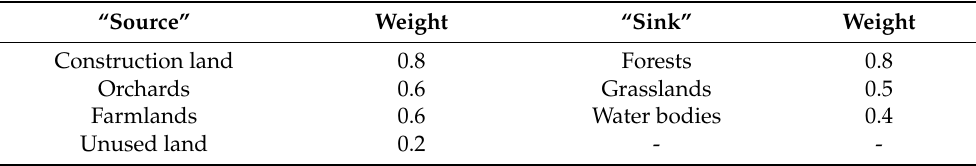
Table 4. Weight of each “source” and “sink” land use type. “Source” Weight “Sink” Weight Construction land